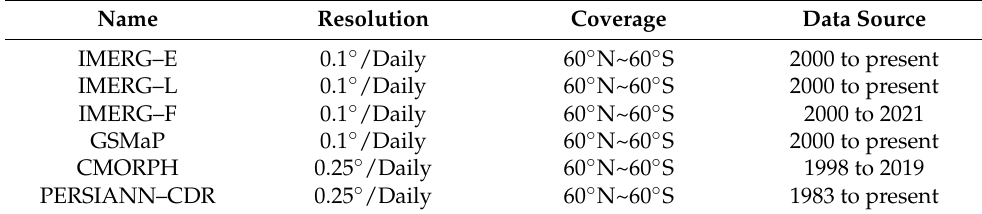
Table 1. Summary of six satellite precipitation products in this